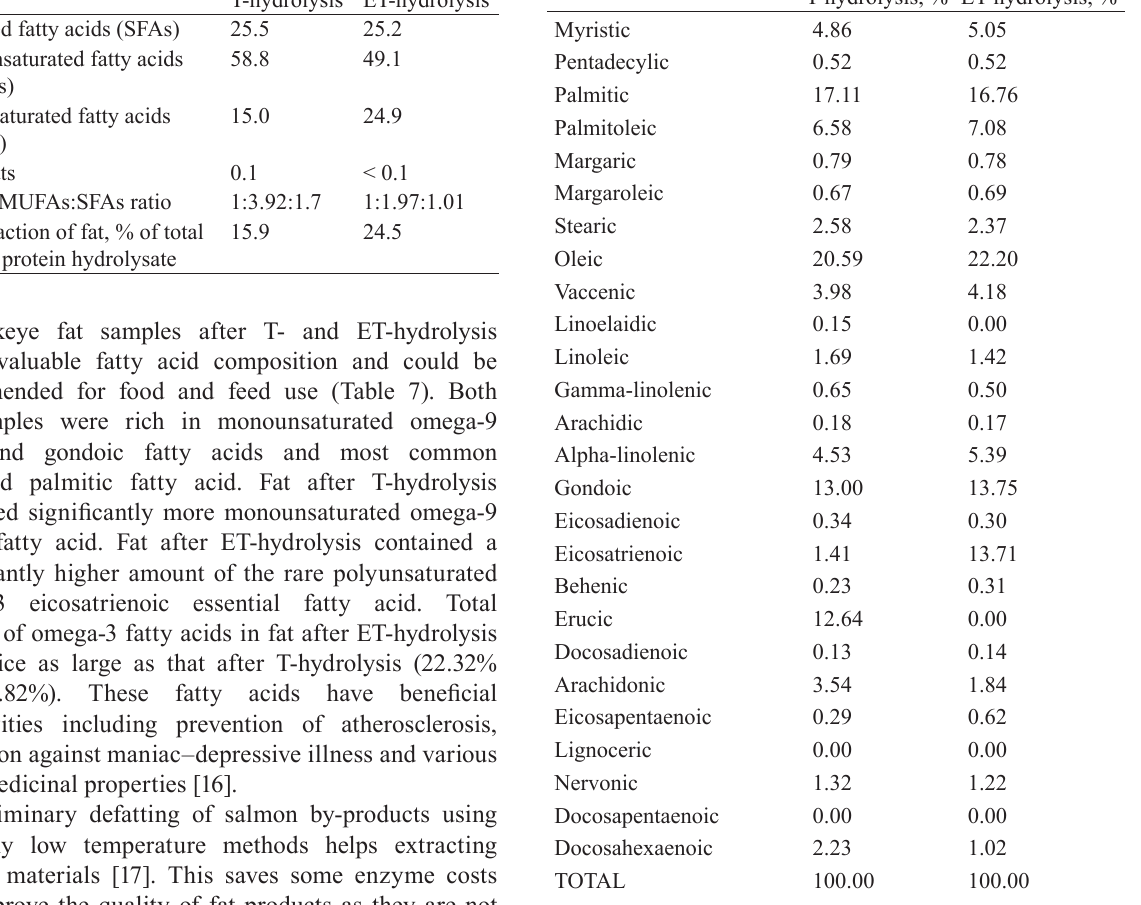
Table 9 Fractional composition of fatty acids in by-products Table 10 Fatty acid composition of fats in by-products from from sockeye heads after thermal and enzymatic-thermal sockeye heads after thermal and enzymatic-thermal hydrolysis hydrolysis Fractions of fatty acids Fatty acid content, % fat Fatty acid By-product T-hydrolysis, % T-hydrolysis ET-hydrolysis Saturated fatty acids (SFAs) 25.5 Monounsaturated fatty acids